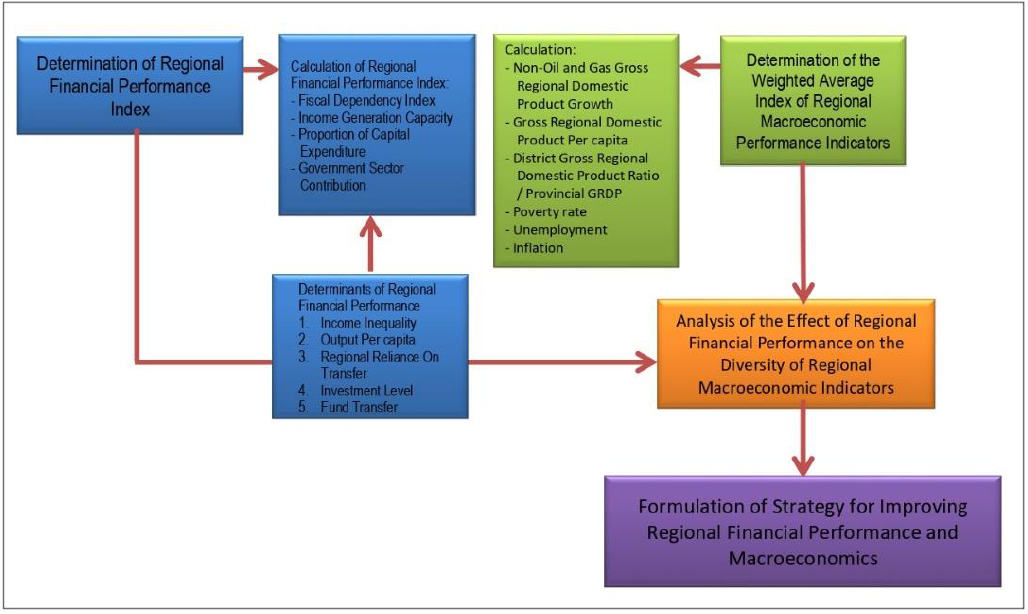
Figure 1: Theoretical and Conceptual